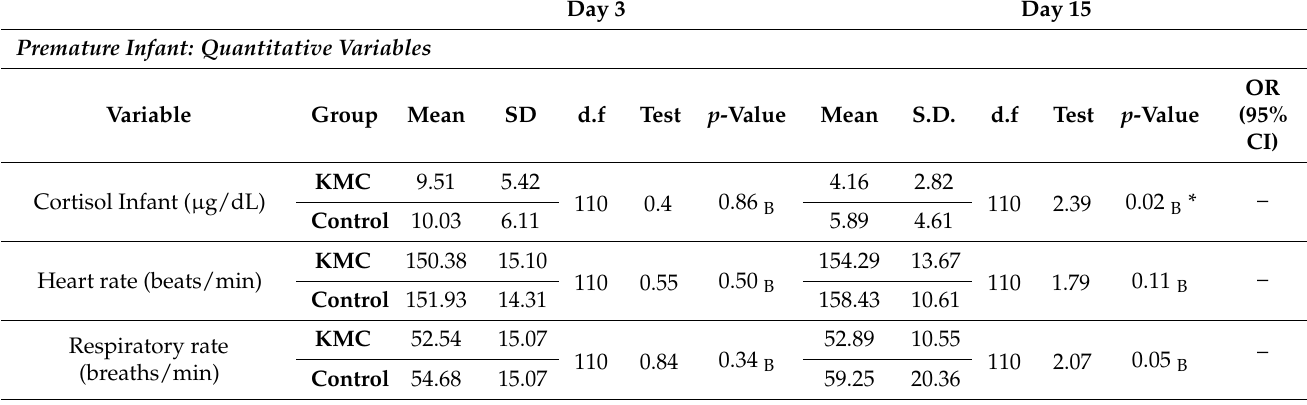
Table 2. Effects of Kangaroo Mother Care on Physiological Parameters (N =